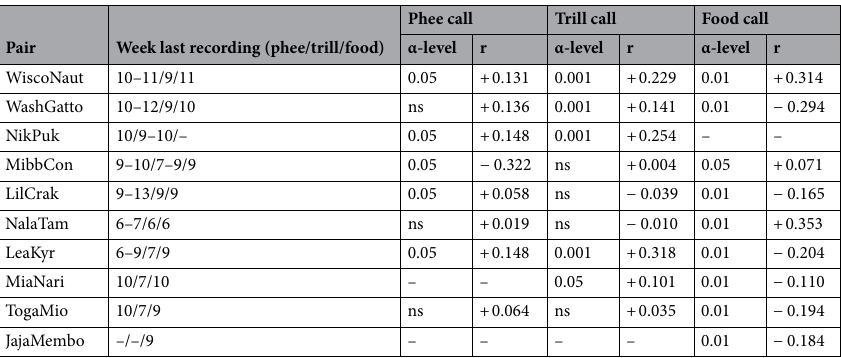
Table 2. Amount of accommodation (convergence and divergence) for each pair and call type. Week refers to the week after pair formation when the recordings for the “after”-comparison were made (for phee-/trill-/ and food calls respectively). α-level gives the level at which the vocal distance was significantly different before and after pair formation (ns indicates that the change in distance was not significant). r indicates the effect size, while the + or − indicates the direction of the effect. Positive r values indicate convergence, i.e. that the pair became more similar, negative r values indicate